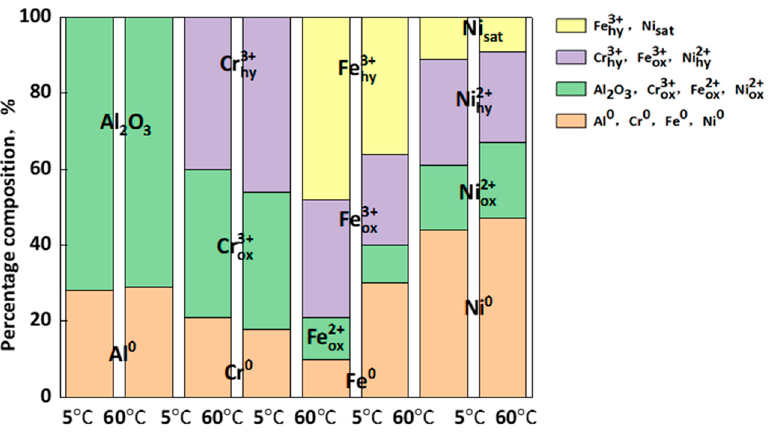
Figure 11. Atomic percentages of the component peaks to the total intensity of Al 2p, Fe 2p3/2, Cr 2p3/2, Ni 2p3/2, and O 1s in the film on AlCoCrFeNi 2.1 in the acid solutions at 5 ℃ and 60 ℃ .